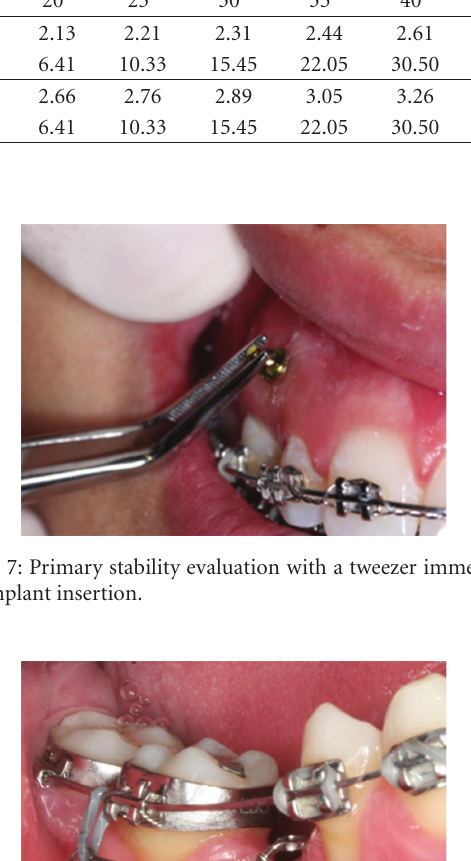
Table 1: Influence of the angulation of the orthodontic implant and the OI-bone interface contact (BIC). Cortical thickness